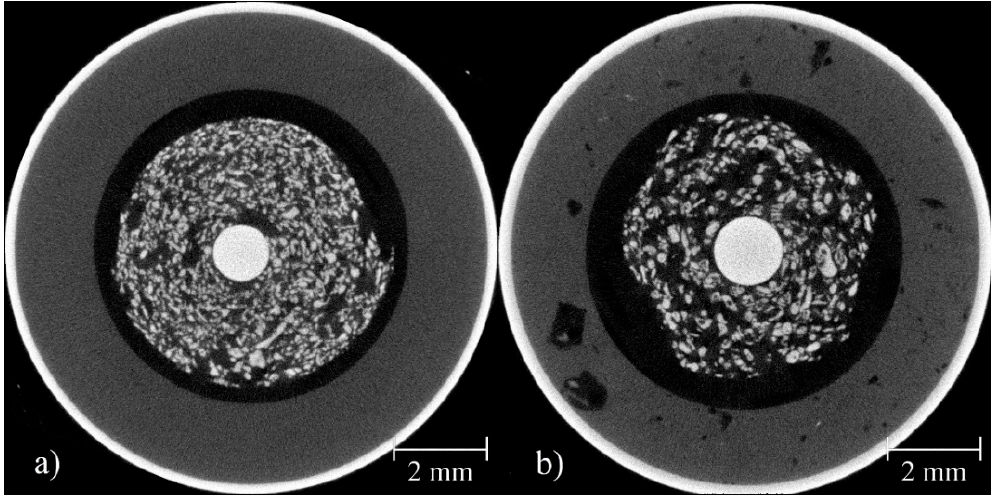
Figure 7. Comparative cut of the primary cell ( a ) and the RAM battery ( b ). Both cells are shown in their pristine state.